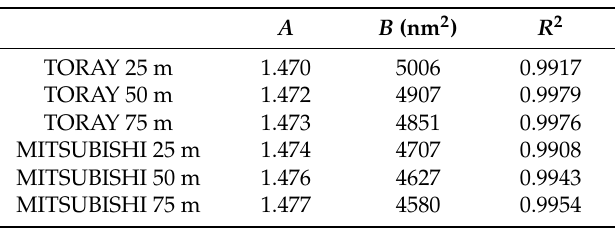
Table 2. Coefficients A and B of Equation (3) together with the corresponding coefficient of determination of the fittings ( R 2